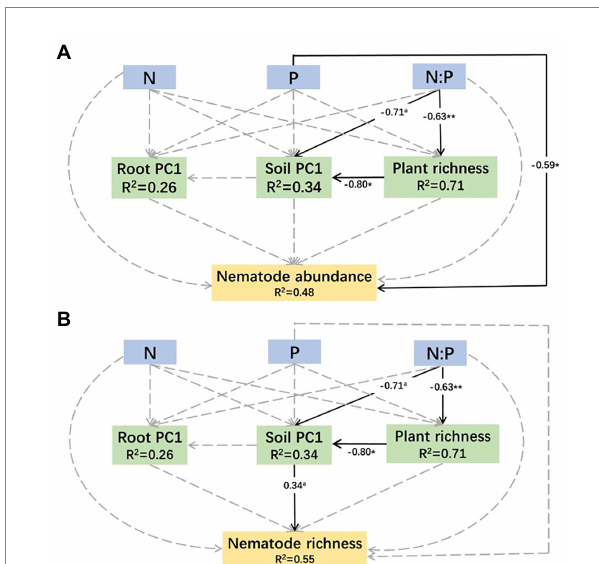
FIGURE 2 SEM analysis showed the interaction between plant and soil and its effects on (A) soil nematode abundance (AIC = 60, Fisher’s C = 0, p = 1) and (B) richness (AIC = 60, Fisher’s C = 0, p = 1). Roots and soils are represented by principal component analysis (PCA) of the reduced dimensional first principal component, respectively. Root functional property variables include all indices measured, and soil physicochemical property variables include so-measured soil physicochemical indicators. Boxes in the model represent individual variables; solid arrows represent significant effects ( p < 0.1); dashed arrows represent non-significant effects ( p > 0.1); numbers on the arrows represent path coefficients. R 2 values represent the variance of response variables explained by other variables. ***: p < 0.001; **: p < 0.01; *: p < 0.05; a: p <